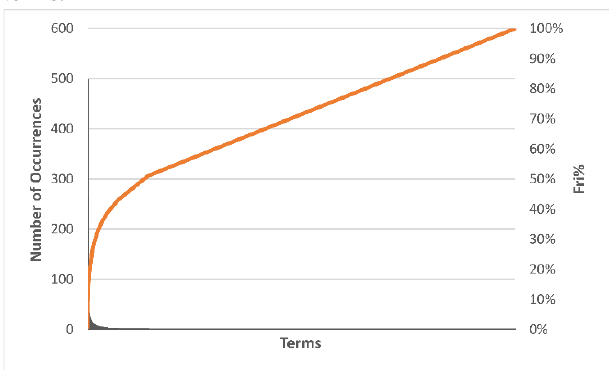
Figure 3. Histogram of the N2 (36.950) terms from